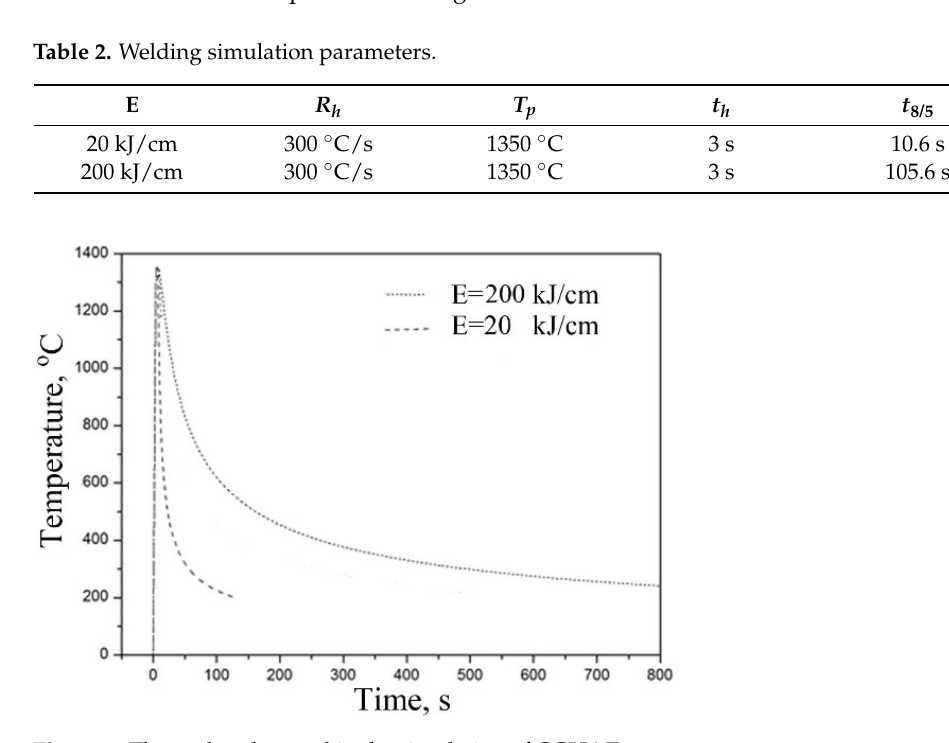
Figure 1. Thermal cycles used in the simulation of